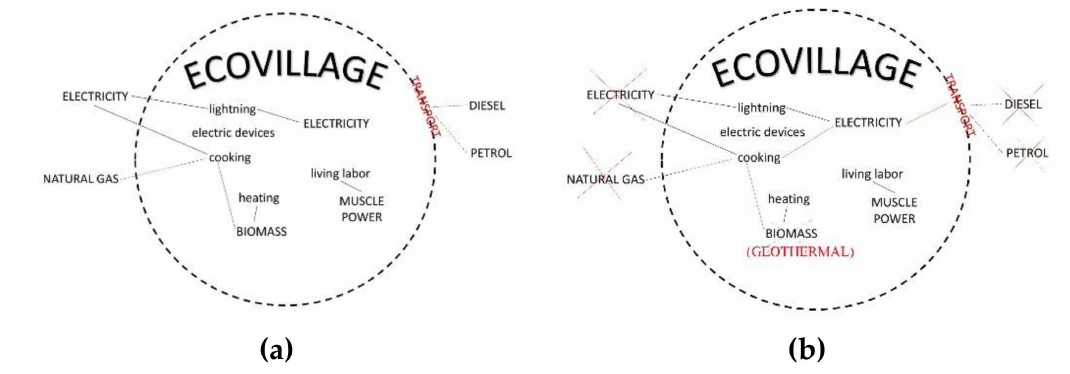
Figure 11. Space structure of energy system of small-scale industry in Visnyesz é plak ( a ) present ( b ) prospective.